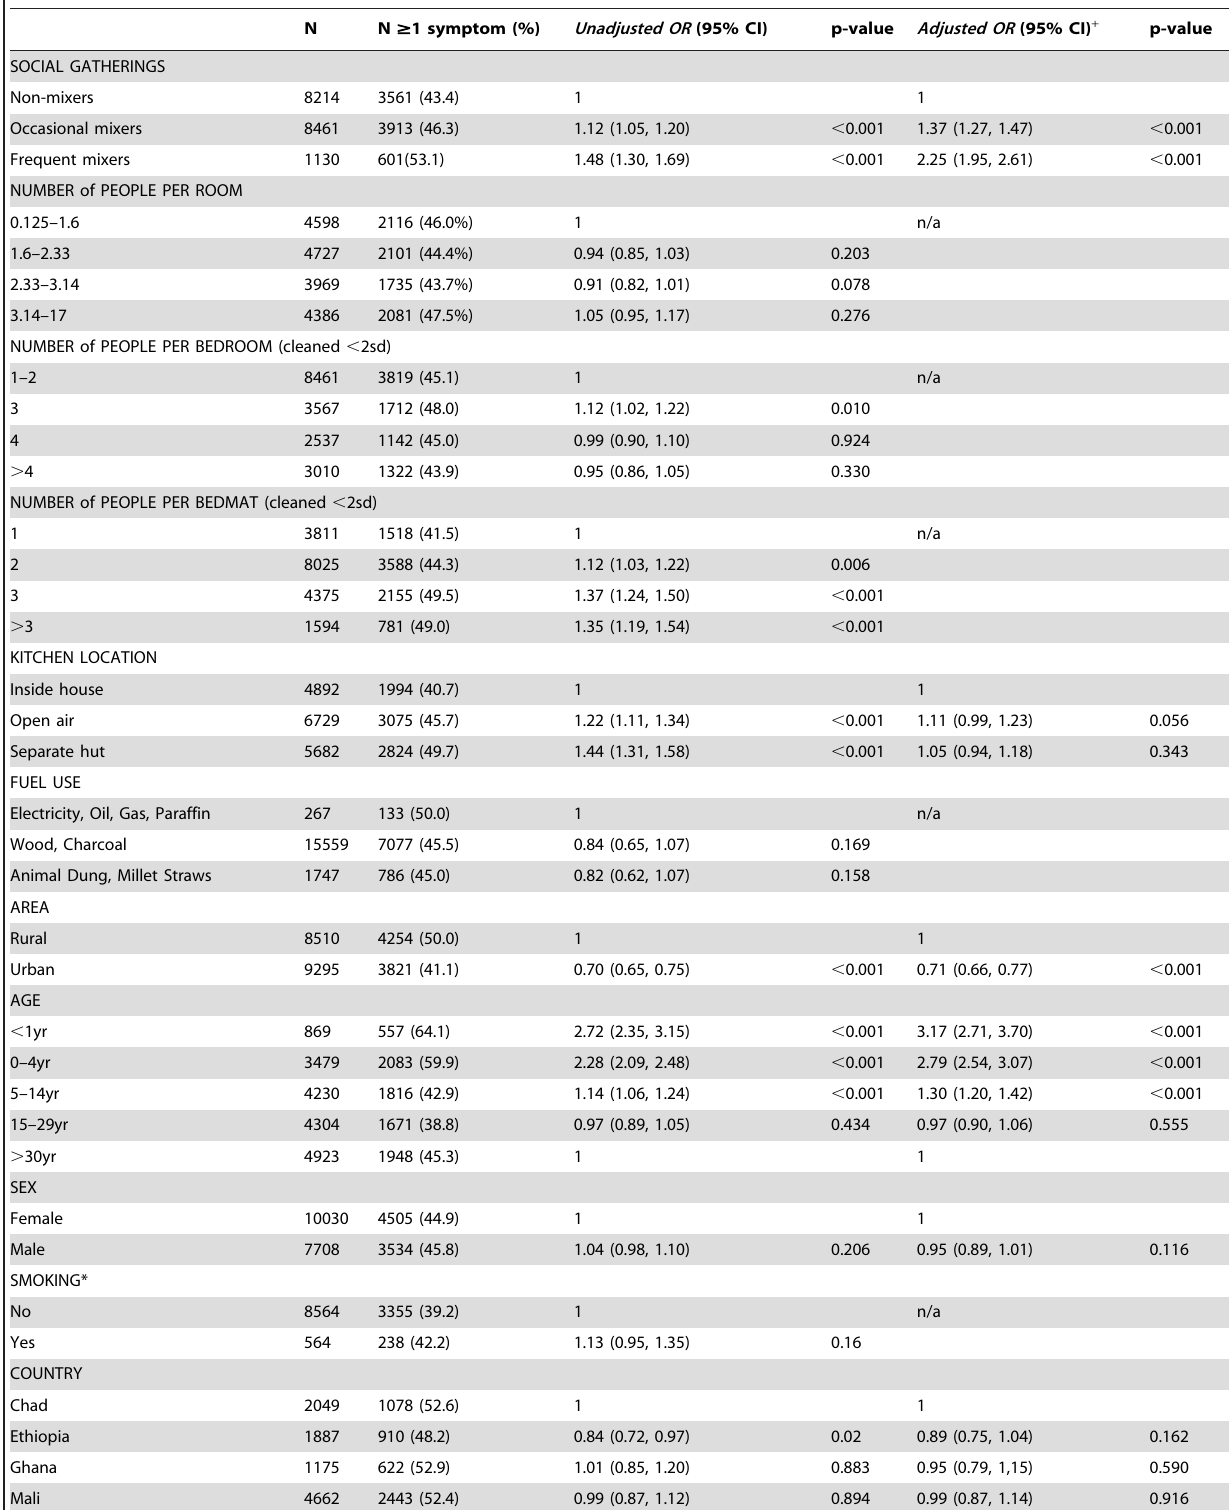
Table 4. Factors associated with reporting respiratory symptoms in the last week.